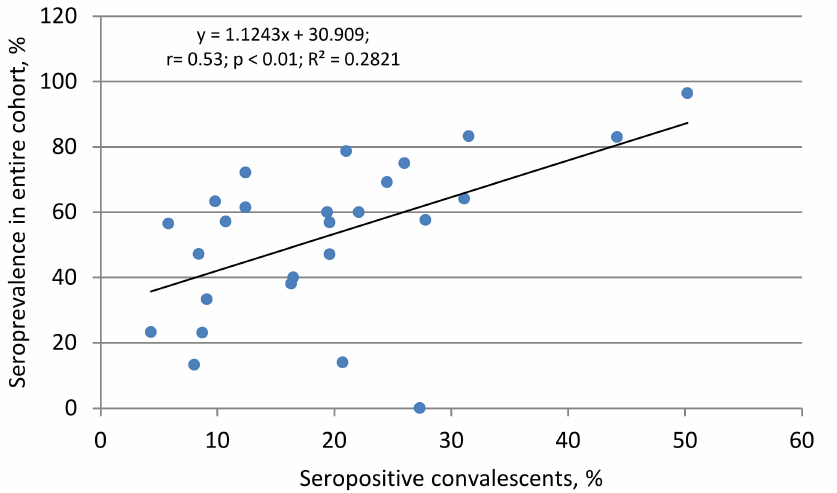
Figure 7. Correlation between seropositivity in the cohort as a whole and the proportion of seroposi- tive among convalescents. The equation, regression, Spearman correlation coefficient (r), the reliability of relationship ( p ), and the coefficient of determination are given.